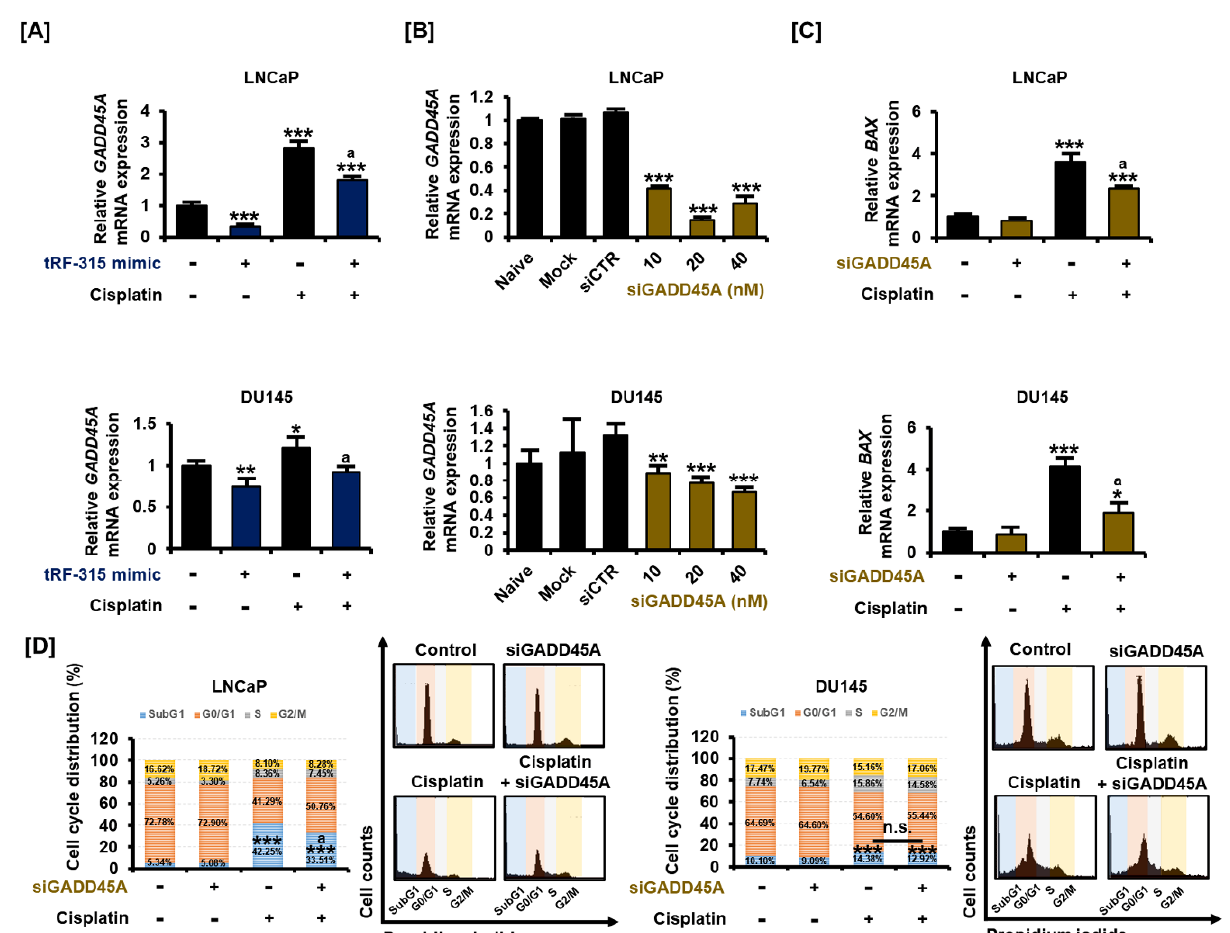
Figure 6. tRF-315 targets GADD45A , which regulates the cell cycle in prostate cancer cells. ( A ) The mRNA expression of GADD45A in LNCaP and DU145 cells in response to tRF-315 mimic (20 nM) for 6 h and cisplatin (20 µ M) for 24 h was measured via quantitative PCR. ( B ) The mRNA expression of GADD45A in LNCaP and DU145 cells in response to siGADD45A (10, 20, and 40 nM) for 6 h was measured via quantitative PCR. ( C ) The mRNA expression of BAX in in LNCaP and DU145 cells response to siGADD45A (20 nM) for 6 h and cisplatin (20 µ M) for 24 h was measured via quantitative PCR. ( D ) Cell cycle distribution was confirmed through propidium iodide staining. The effect of siGADD45A (20 nM) and cisplatin (20 µ M) on the cell cycle was measured based on the number of cells in the sub G1, G1, S, and G2/M phases. The data represent three independent experiments. The asterisks indicate significant differences between the treated cells and control cells (siCTR) (*** p < 0.001, ** p < 0.01, and * p < 0.01). The symbol ‘a’ indicates a significant difference compared with cisplatin alone treatment group. The symbol ‘n.s.’ indicates that there is no significant difference between the two groups.